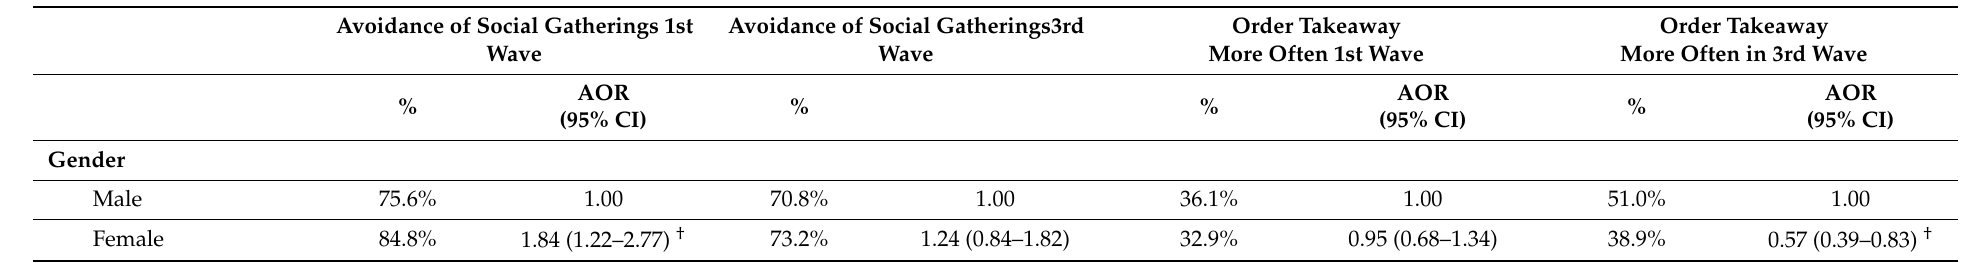
Table A2. Factors associated with compliance with social distancing measures in Hong Kong COVID-19 first wave and third